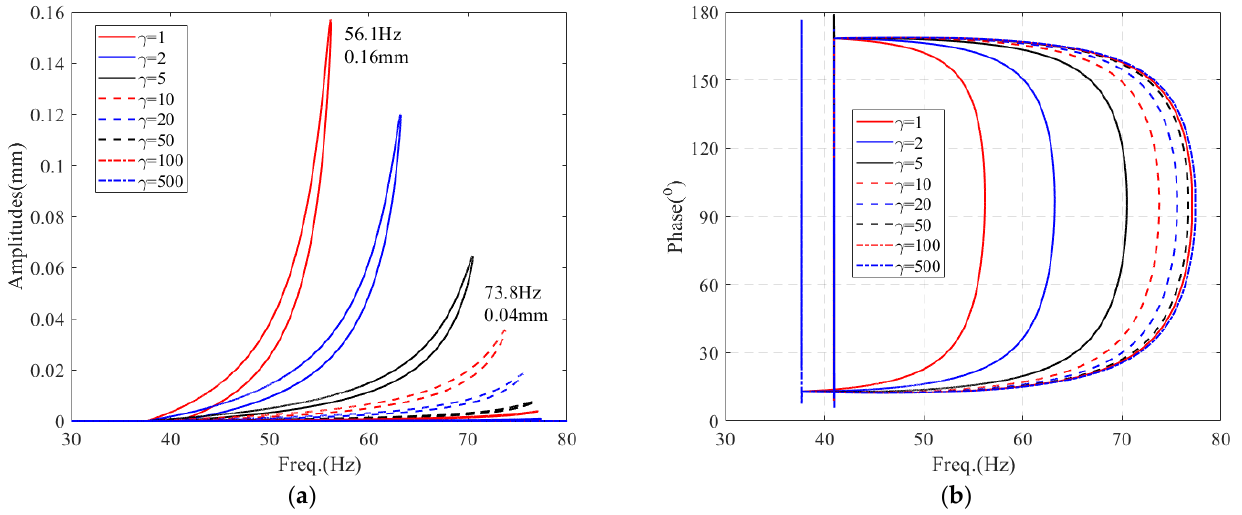
Figure 25. Influences of γ on amplitude – frequency and phase – frequency characteristics of 3# bearing: ( a ) amplitude – frequency characteristics; ( b ) phase – frequency characteristics.